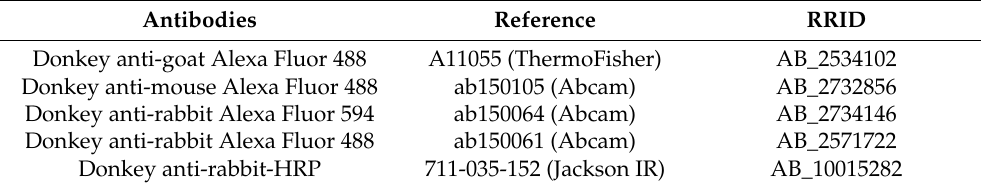
Table 3. Secondary